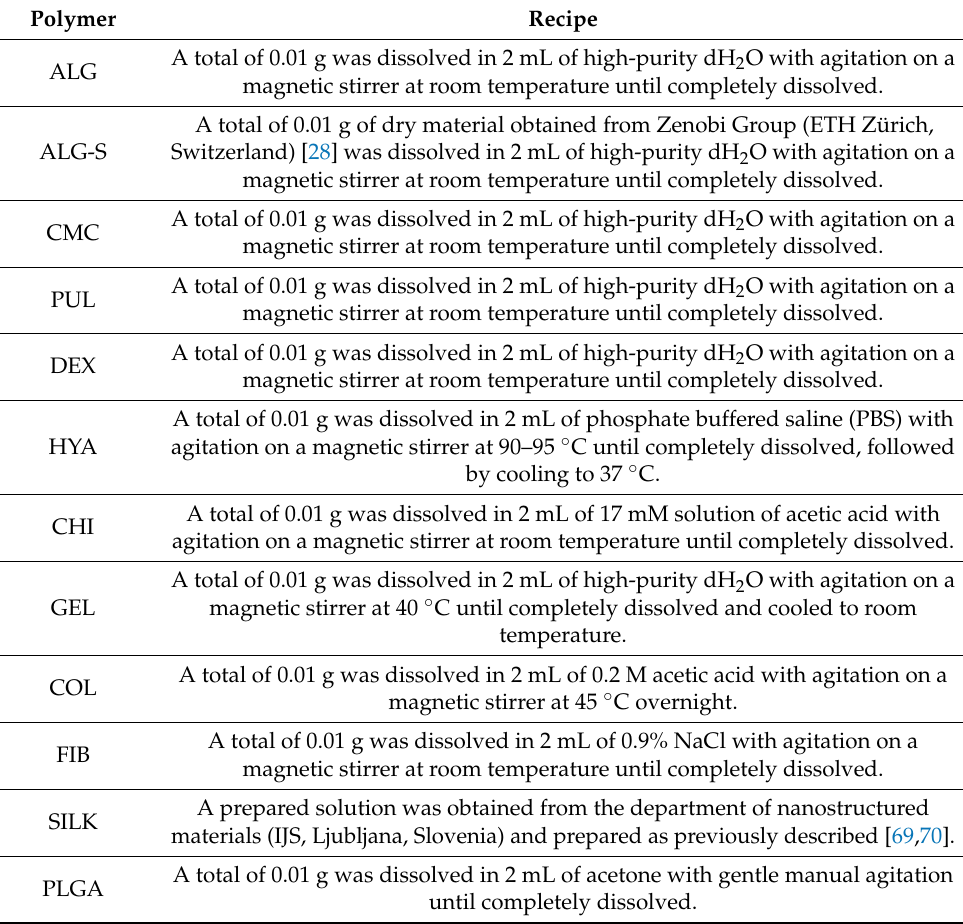
Table 2. A summary of the materials used and prepared